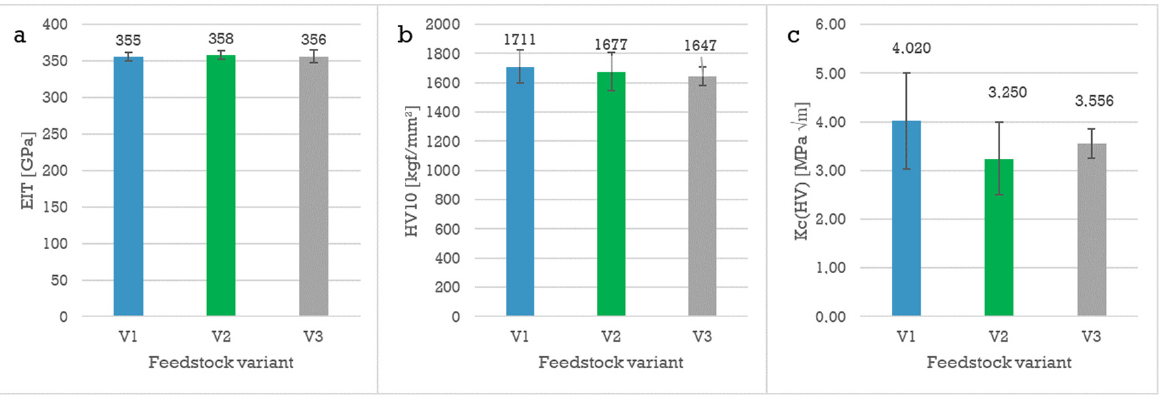
Figure 11. Indentation modulus ( a ), Vickers hardness HV10 ( b ), indentation toughness after Niihara ( c ).